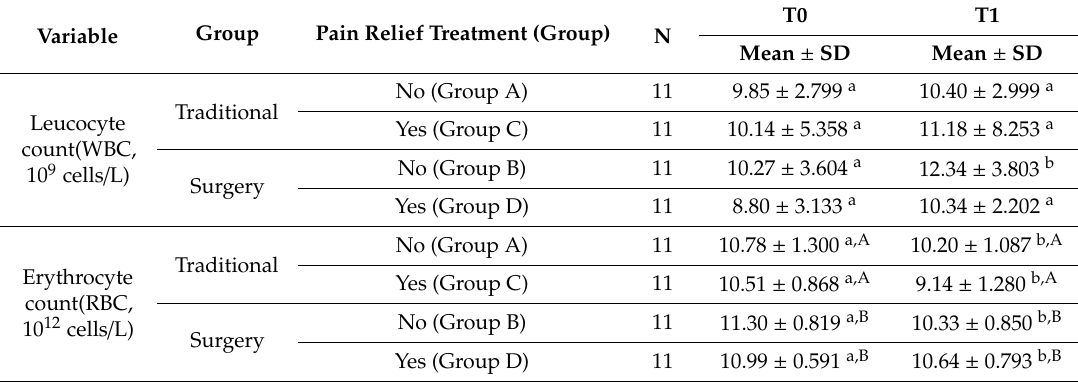
Table 3. Mean and SD of the leucocyte (WBC, 10 9 cells / L) and erythrocyte counts (RBC, 10 12 cells / L) at T0 (immediately prior to tail docking) and T1 (seven days after procedure), where “Surgery” was tail docking performed under general anaesthesia (Groups B and D), “Traditional” was tail docking conducted without general anaesthesia (Groups A and C), and ‘yes’ or ‘no’ was with or without PR, treatment applied, respectively. a,b ; di ff erent letters mean significant di ff erences between T0 and T1 ( p < 0.05). A,B ; di ff erent letters mean significant di ff erences between Traditional and Surgery groups for RBC in both T0 and T1 ( p <